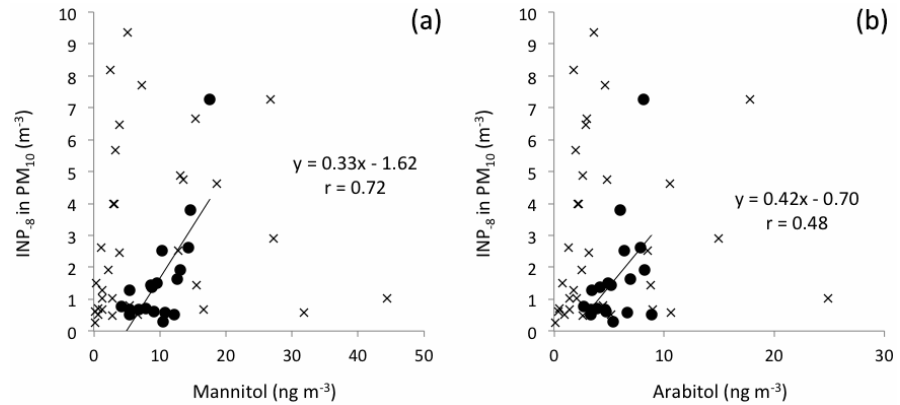
Figure 6. Correlation between INP − 8 and the fungal markers mannitol (a) and arabitol (b) for the time period from 14 May to 24 Septem- ber 2014 (black circles, regression line and equation are fitted to these data). Concentrations of INP − 8 before and after this period (crosses) did not correlate with either fungal spore